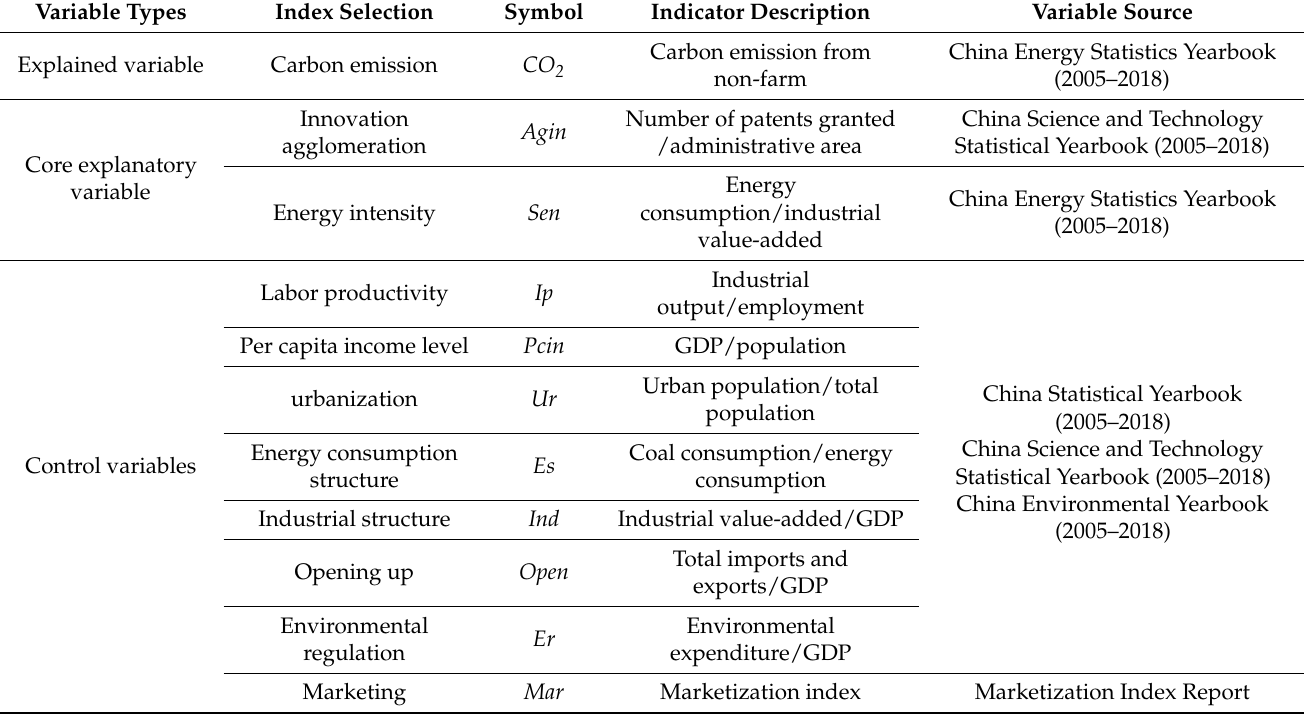
Table 2. Data Selection &